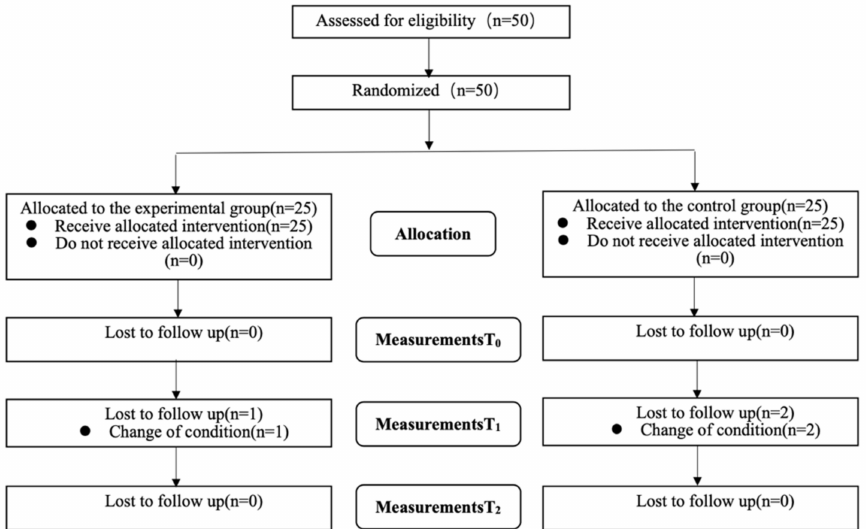
Figure 3. Flowchart (T 0 : baseline; T 1 : four weeks from baseline; T 2 : four weeks after completion of the